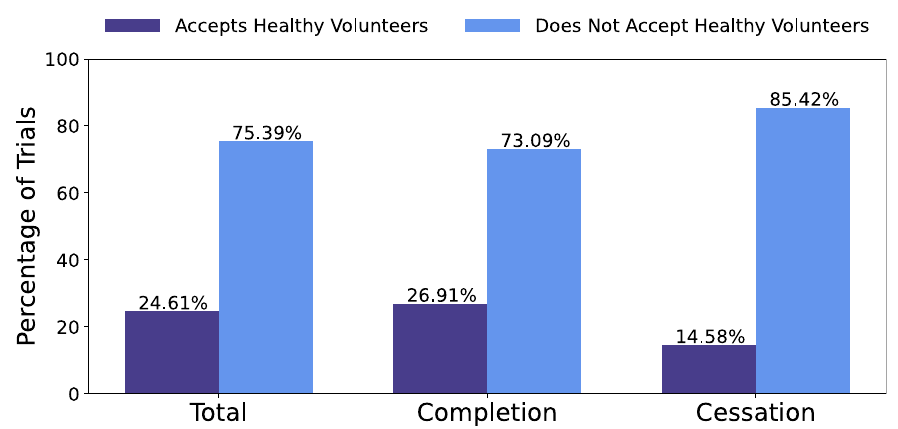
Fig 8. Distribution of trials accepting healthy volunteers with respect to all trials, completion trials, and cessation trials, respectively.